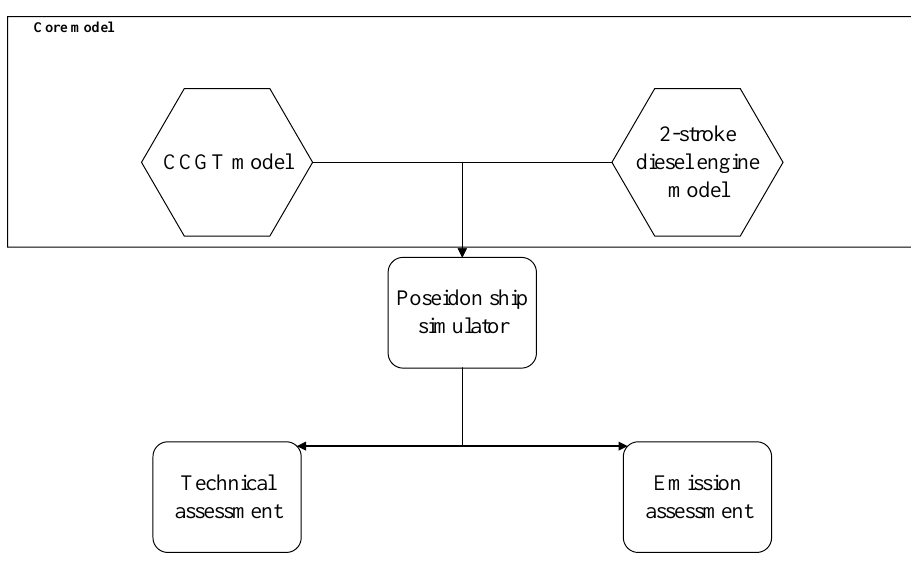
Figure 1. Flow diagram of the methodology used in this study. CCGT: gas and steam combined cycle. Table 1. CCGT engines with different fuels.